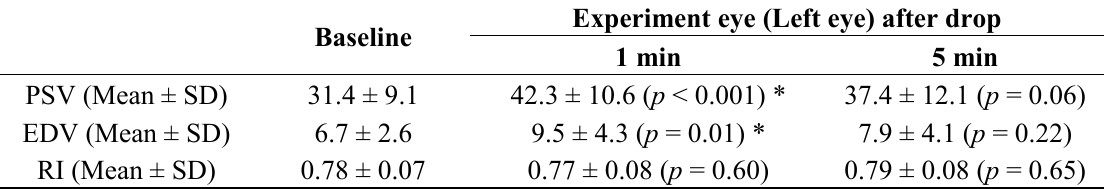
Table 3. Stage 2: Baseline and drop comparison after 1 min and 5